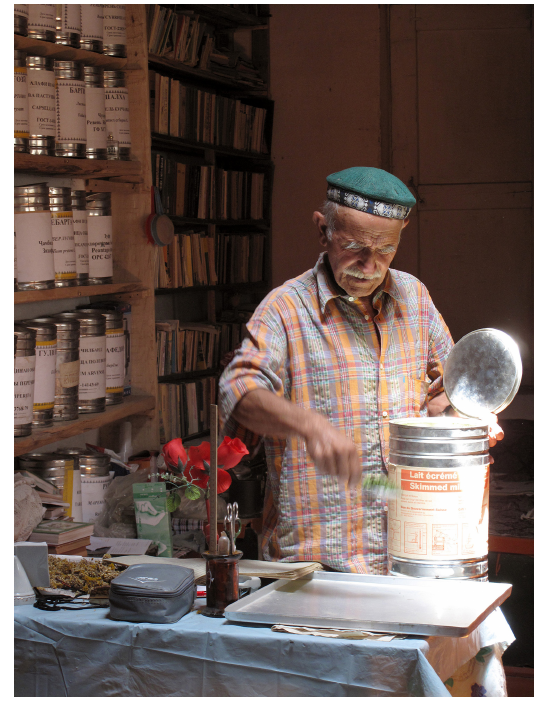
Fig. 3. A Pamiri doctor prepares a tea that has become a popular remedy against stomach parasites such as Giardia. In the tins behind him are the plants he finds in the mountains around his home and which he uses to make his natural medicines. Photograph by Jamila